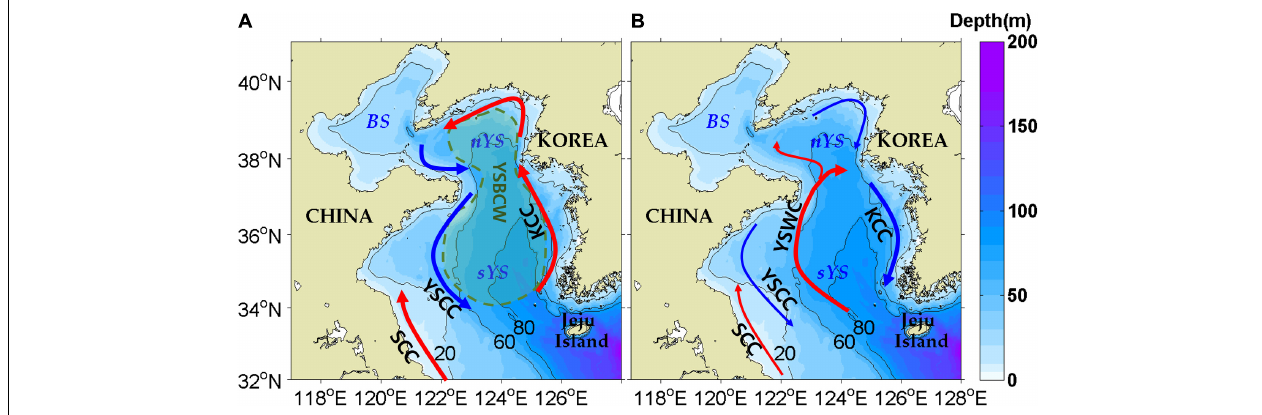
FIGURE 1 | Schematic diagrams of ocean currents during summer (A) and winter (B) in the Yellow Sea. KCC, SCC, YSCC, YSBCW, YSWC, BS, nYS, and sYS indicate the Korean Coastal Current, Subei Coastal Current, Yellow Sea Coastal Current, Yellow Sea Bottom Cold Water, Yellow Sea Warm Current, Bohai Sea, northern Yellow Sea, and southern Yellow Sea,